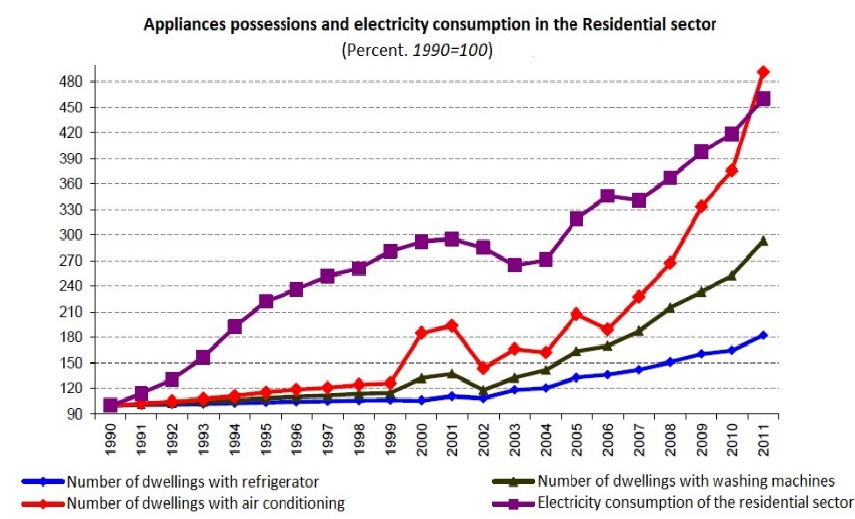
Figure 5. Appliances possessions and Electricity consumption in the Residential sector [52].